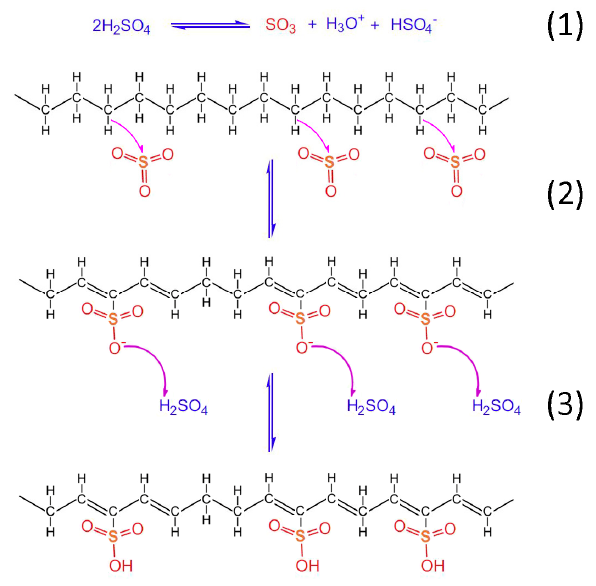
Figure 12. Chemical reactions of HDPE/SKL (90:10) fiber sulfonation.